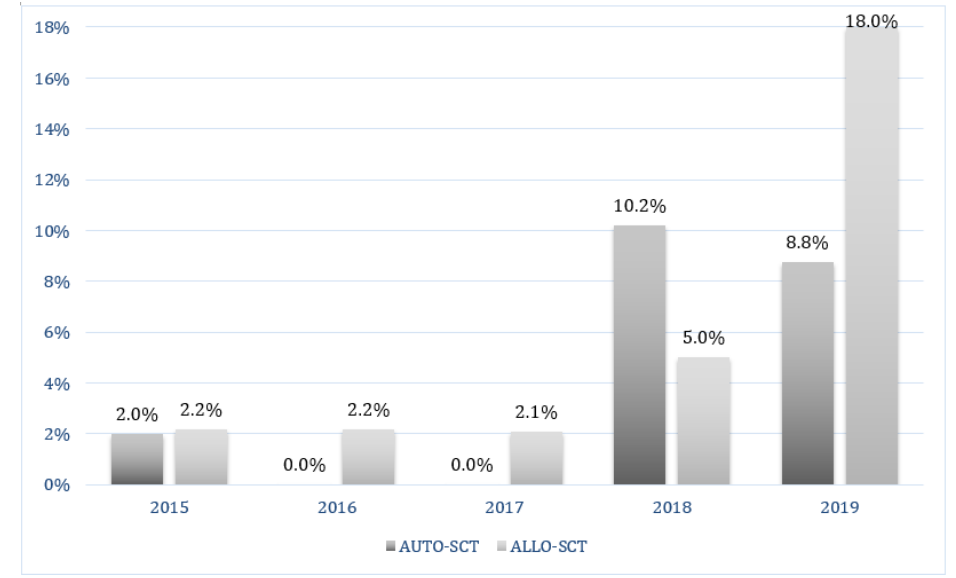
Figure 2. CDI cases for years. CDI = clostridium difficile infection; SCT = stem cell transplantation. In total, 11 patients had received auto-HSCT and 15 had undergone allo-HSCT. The cumulative incidence of CDI was 5.4% (95% CI 3.67% to 7.77%) after allo-HSCT, and 4.2 (95% CI 2.6% to 6.3%) after auto-HSCT, with no significant difference between the two types of procedures. Out of 26 patients, 19 (73%) were also positive for toxigenic C. difficile . In particular, 5 out of 26 patients (19%)